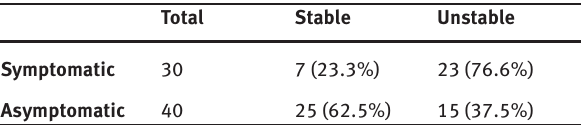
Table 2 : Correlation between plaque stability and symptoms.